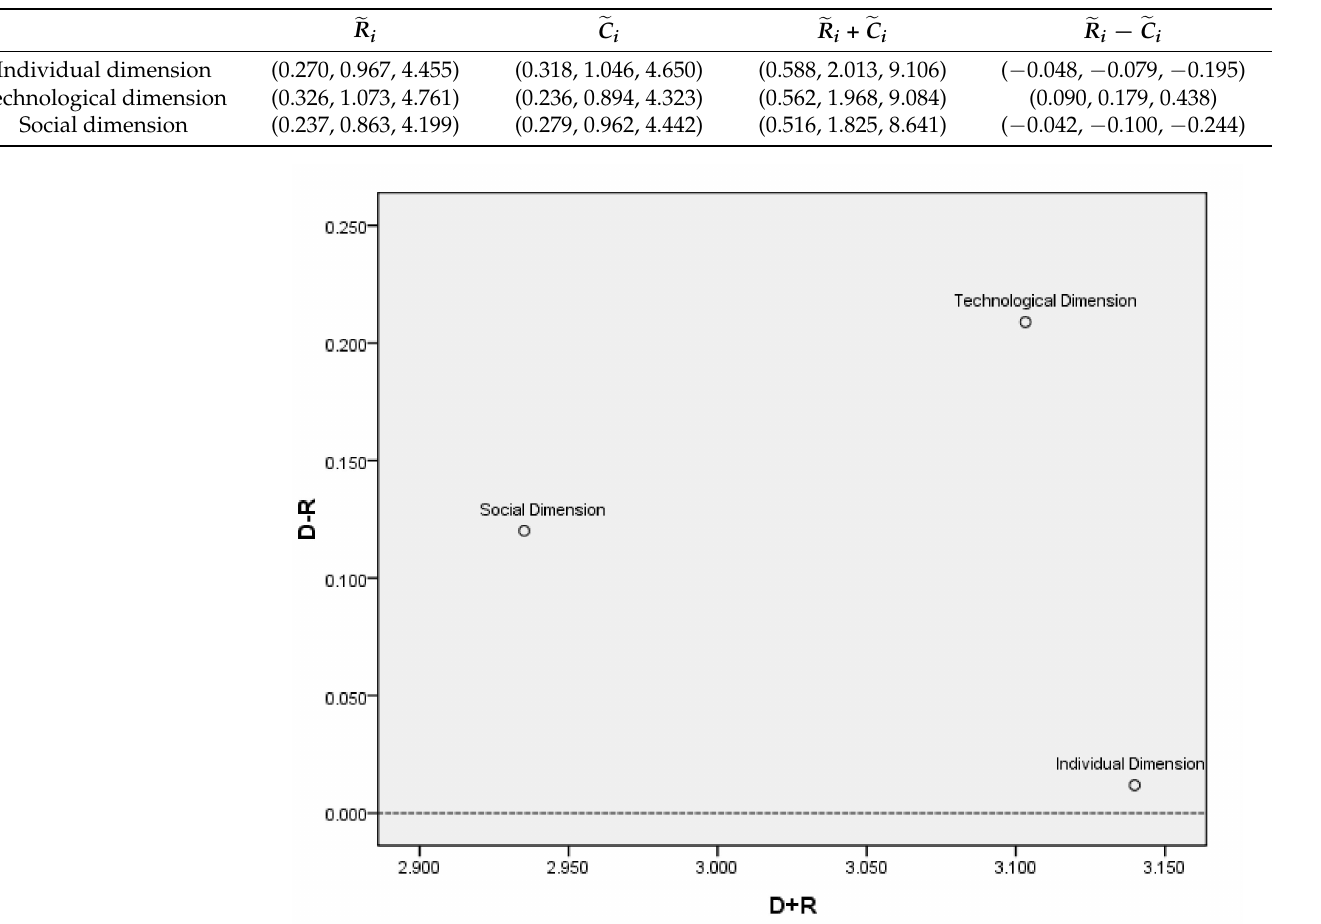
Table 2. Sum of (cid:101) R i , (cid:101) C i , (cid:101) R i + (cid:101) C i , and (cid:101) R i − (cid:101) C i impacts using three measurements.